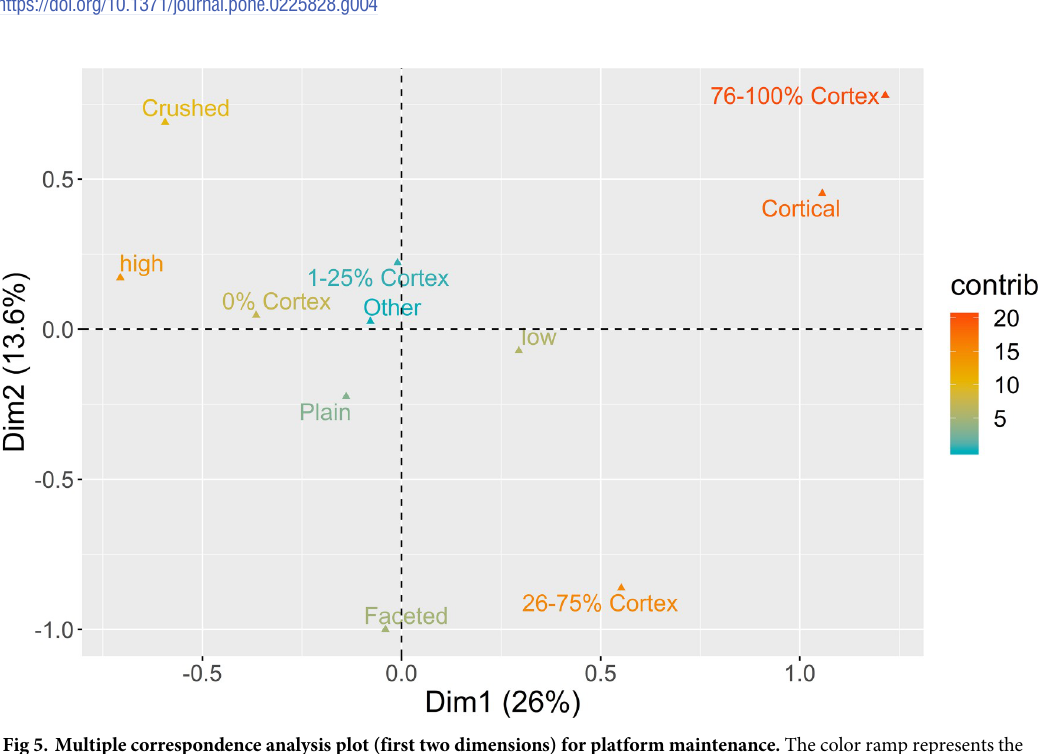
PLOS ONE | https://doi.org/10.1371/journal.pone.0225828 December11,